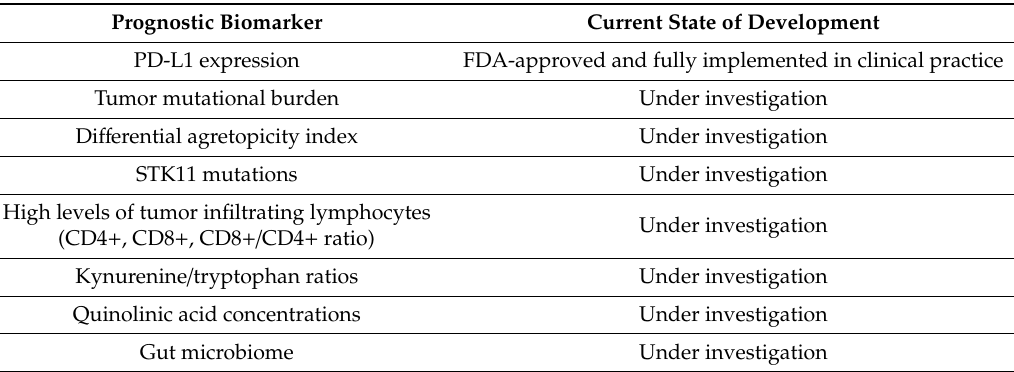
Table 1. Current and promising prognostic biomarkers in non-small cell lung cancer (NSCLC)